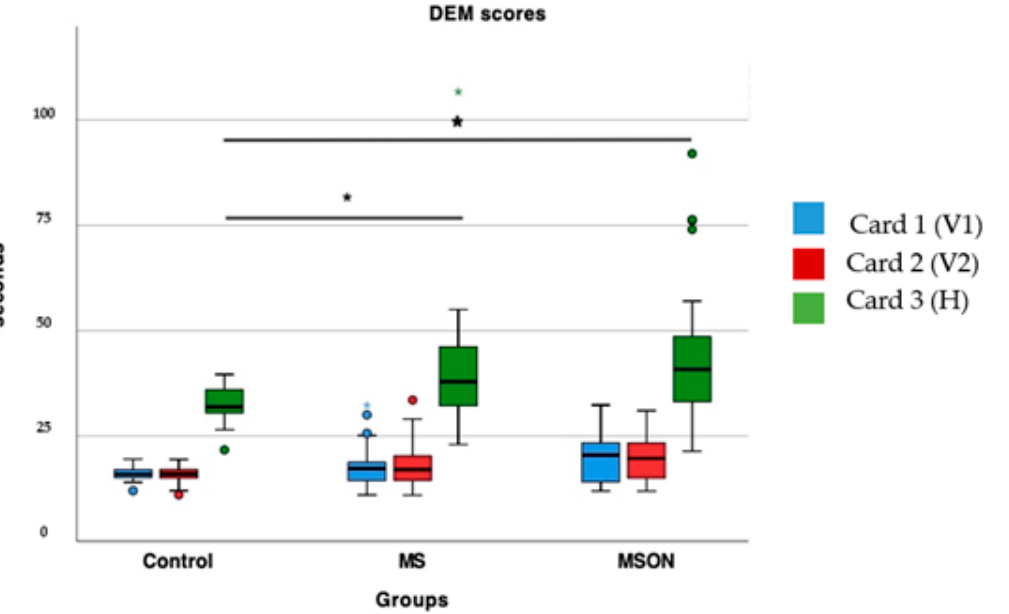
Figure 2. Time spent in completing the cards 1, 2 and 3 of DEM test per group. Cards 1 and 2 were read vertically with different combinations of numbers and separations (V1 and V2), whereas card 3 was read horizontally (H). Statistically significant differences are marked with an asterisk (*). Regarding the DEM ratio, higher values (which can represent normal vertical times with horizontal times increased, or an increase in both components but more in the horizontal component) were found in the MS group, these differences being statistically significant in comparison to the control group ( p < 0.001), but not to the MSON ( p = 0.52). In contrast, the MSON group did not show significant differences with the control group ( p = 0.42) in the ratio, since both vertical and horizontal times were longer than in the control group.